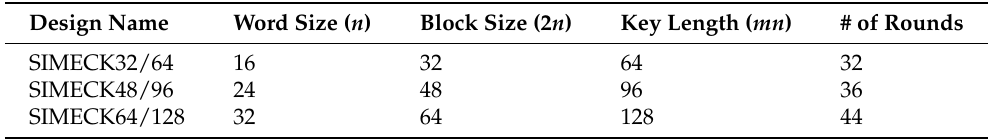
Table 1. SIMECK family of a block cipher. We refer readers to follow Table 1 of [31] for more detailed parameters.